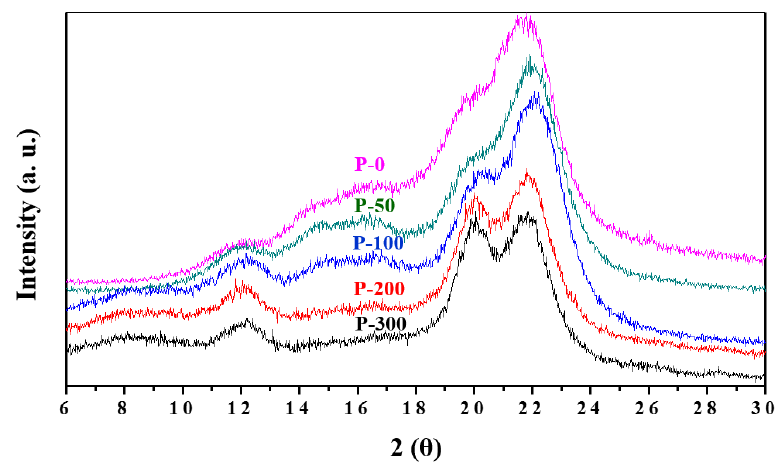
Figure 5. Comparison of XRD analysis of P-0, P-50, P-100, P-200, and P-300.